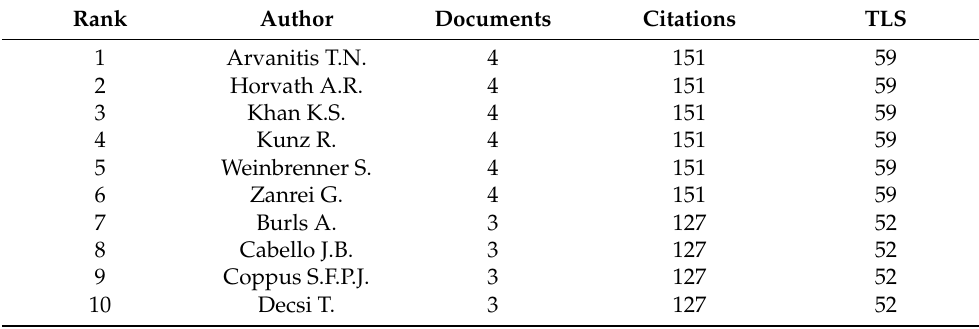
Table 7. The top 10 collaborating Authors in performance evaluation in